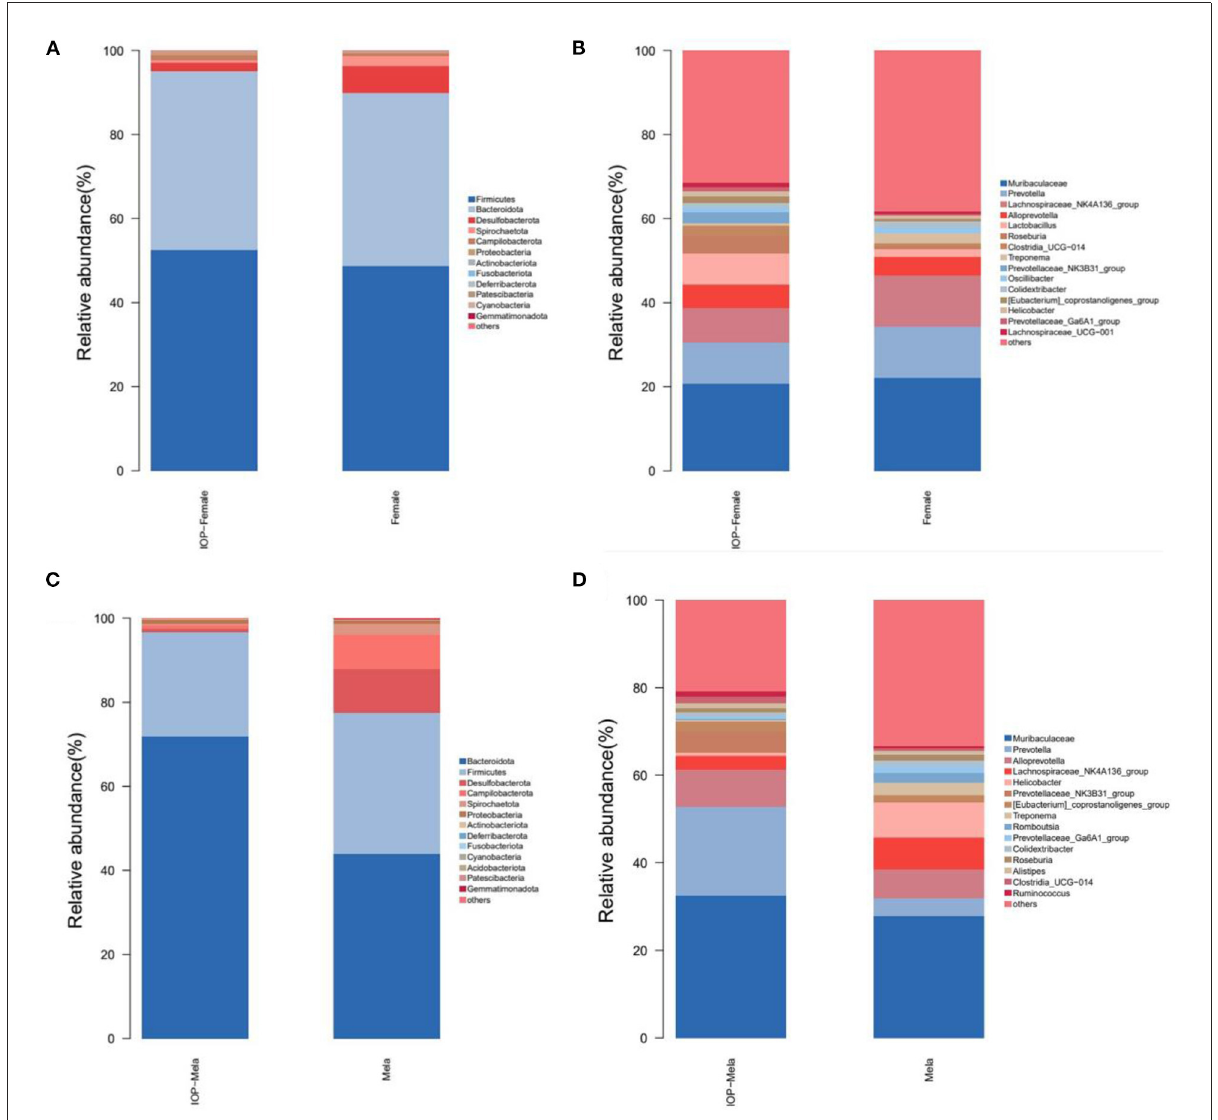
FIGURE5 Histogram showing changes in the composition of intestinal microbes. (A,B) The first 15 different bacteria in female SD rats at phylum and genus levels. (C,D) The first 15 different microorganisms in male SD rats at phylum and genus levels.